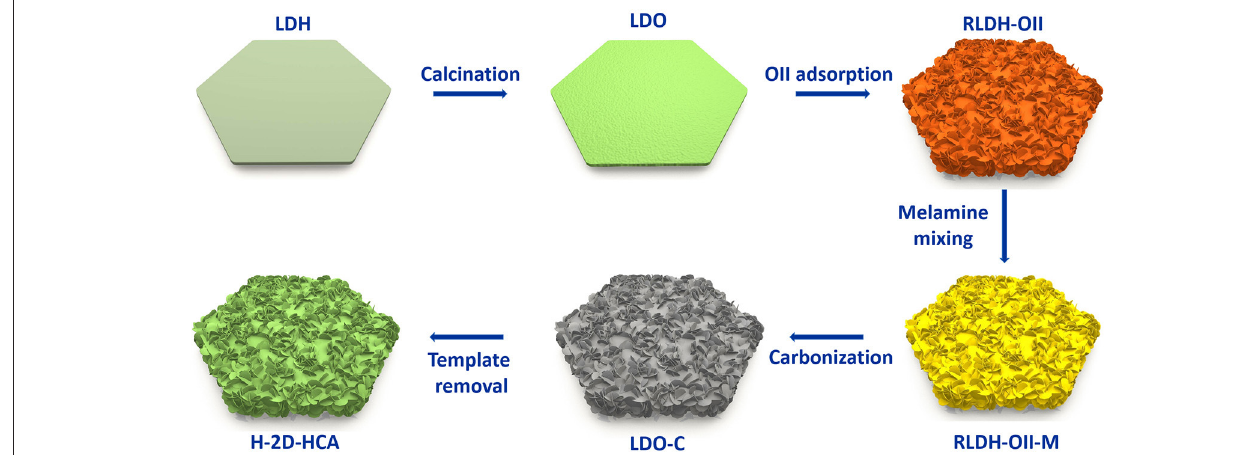
FIGURE 1 | Synthesis approach of H-2D-HCA.